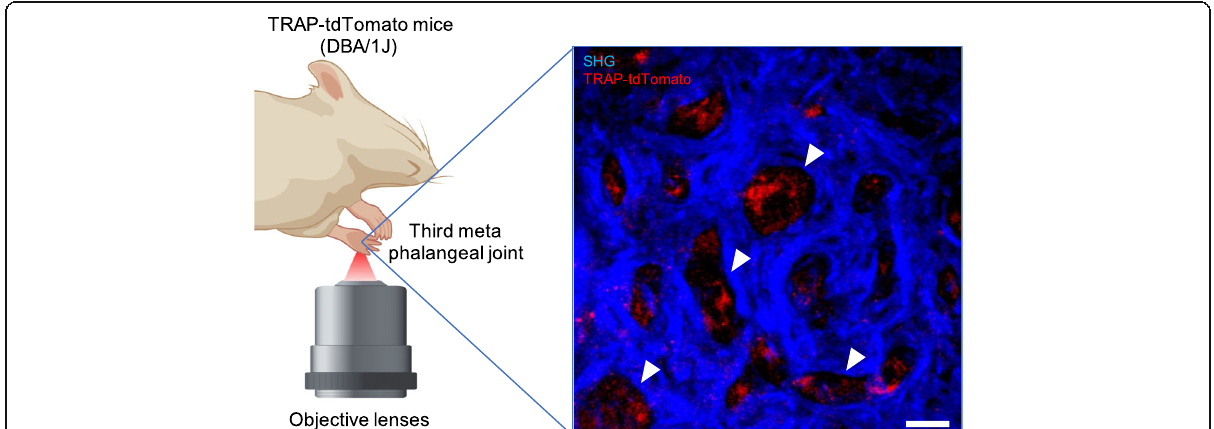
Fig. 3 Observation of osteoclasts in the interface between the inflamed synovium and bone surface. Osteoclasts were observed using an inverted two-photon microscopy. This is a representative result. Blue, second-harmonic generation (SHG); Red, TRAP-tdTomato; Arrow heads, representative bone resorption bits; Scale bar: 30 μ